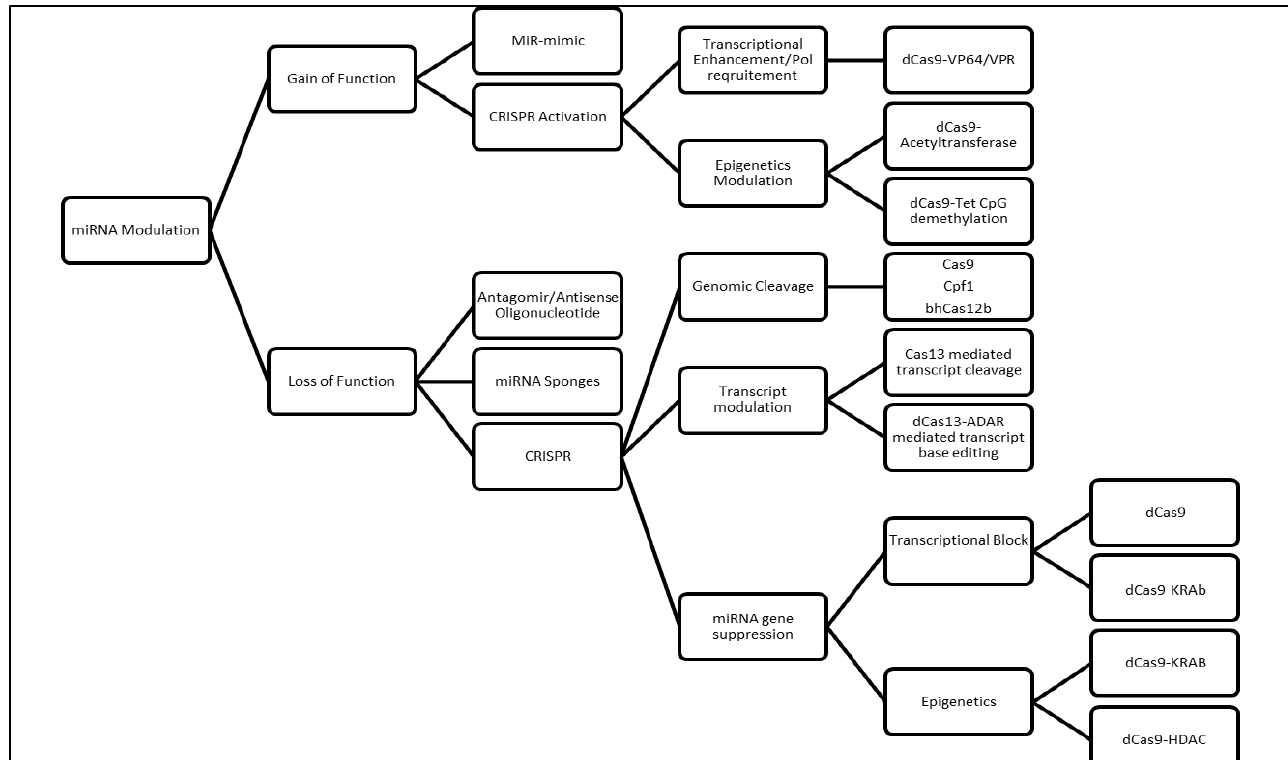
Figure 7. General workflow for studying miRNA dysfunction in cancer. Depending on experimental design miRNA study could be assessed via knock-in or loss of function study. Several CRISPR-based methods are available as listed in Figure for the desired